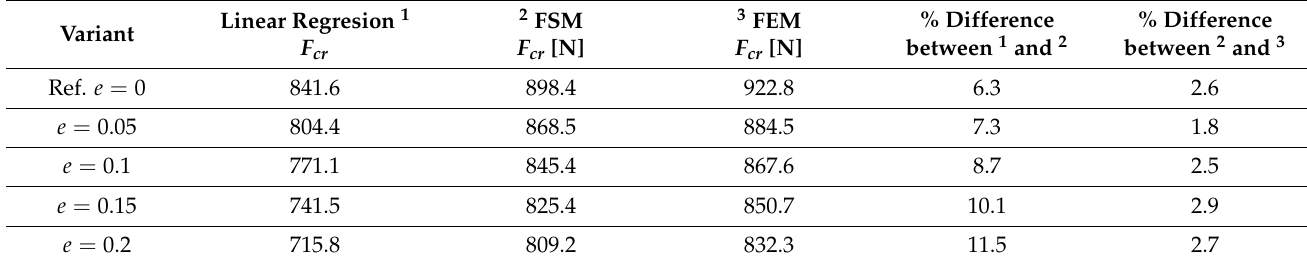
Table 8. Determining the levels of critical forces by individual methods of